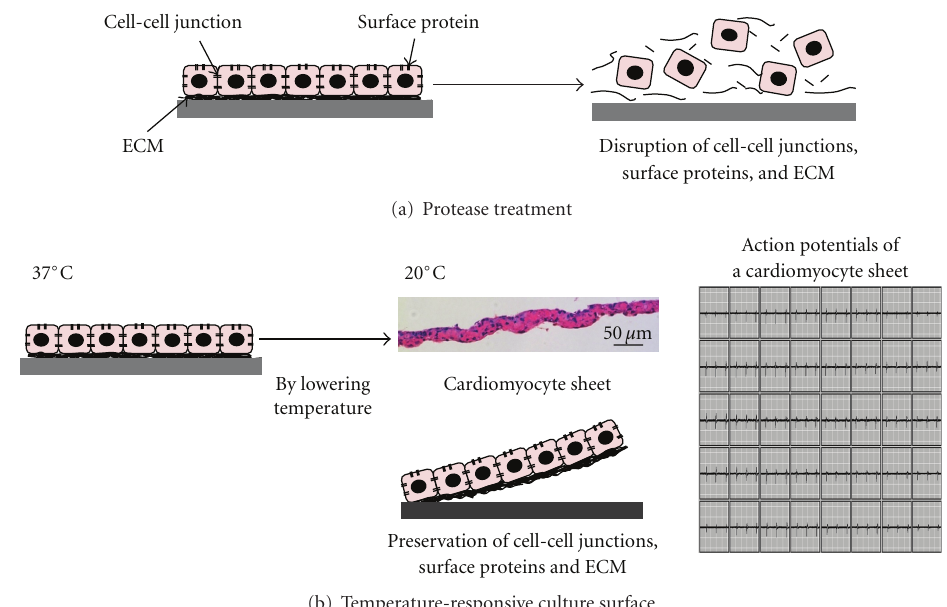
Figure 1: The preparation of a cardiomyocyte sheet using a temperature-responsive culture dish without protease treatment. Typical cell harvest using proteases results in the disruption of cell-cell junctions including gap junctions, cell surface proteins including gap junction precursors, and extracellular matrix (ECM) (a). When temperature-responsive culture surfaces are used, the structures of cells are preserved and cultured cardiomyocytes are released as a contiguous cell sheet (b). A microphotograph shows the cross-sectional view of a cardiomyocyte sheet. Electrograms show the spontaneous action potentials of a cardiomyocyte